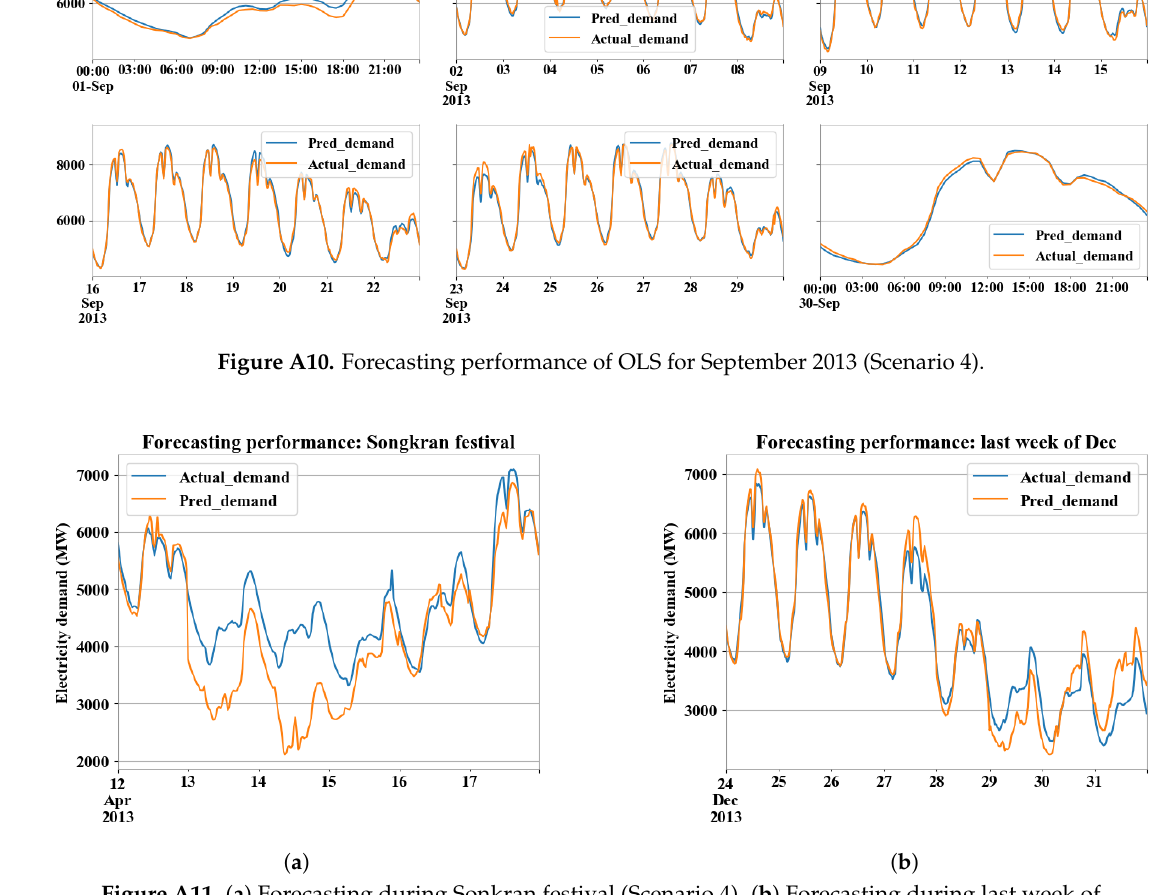
Figure A11. ( a ) Forecasting during Sonkran festival (Scenario 4). ( b ) Forecasting during last week of December (Scenario